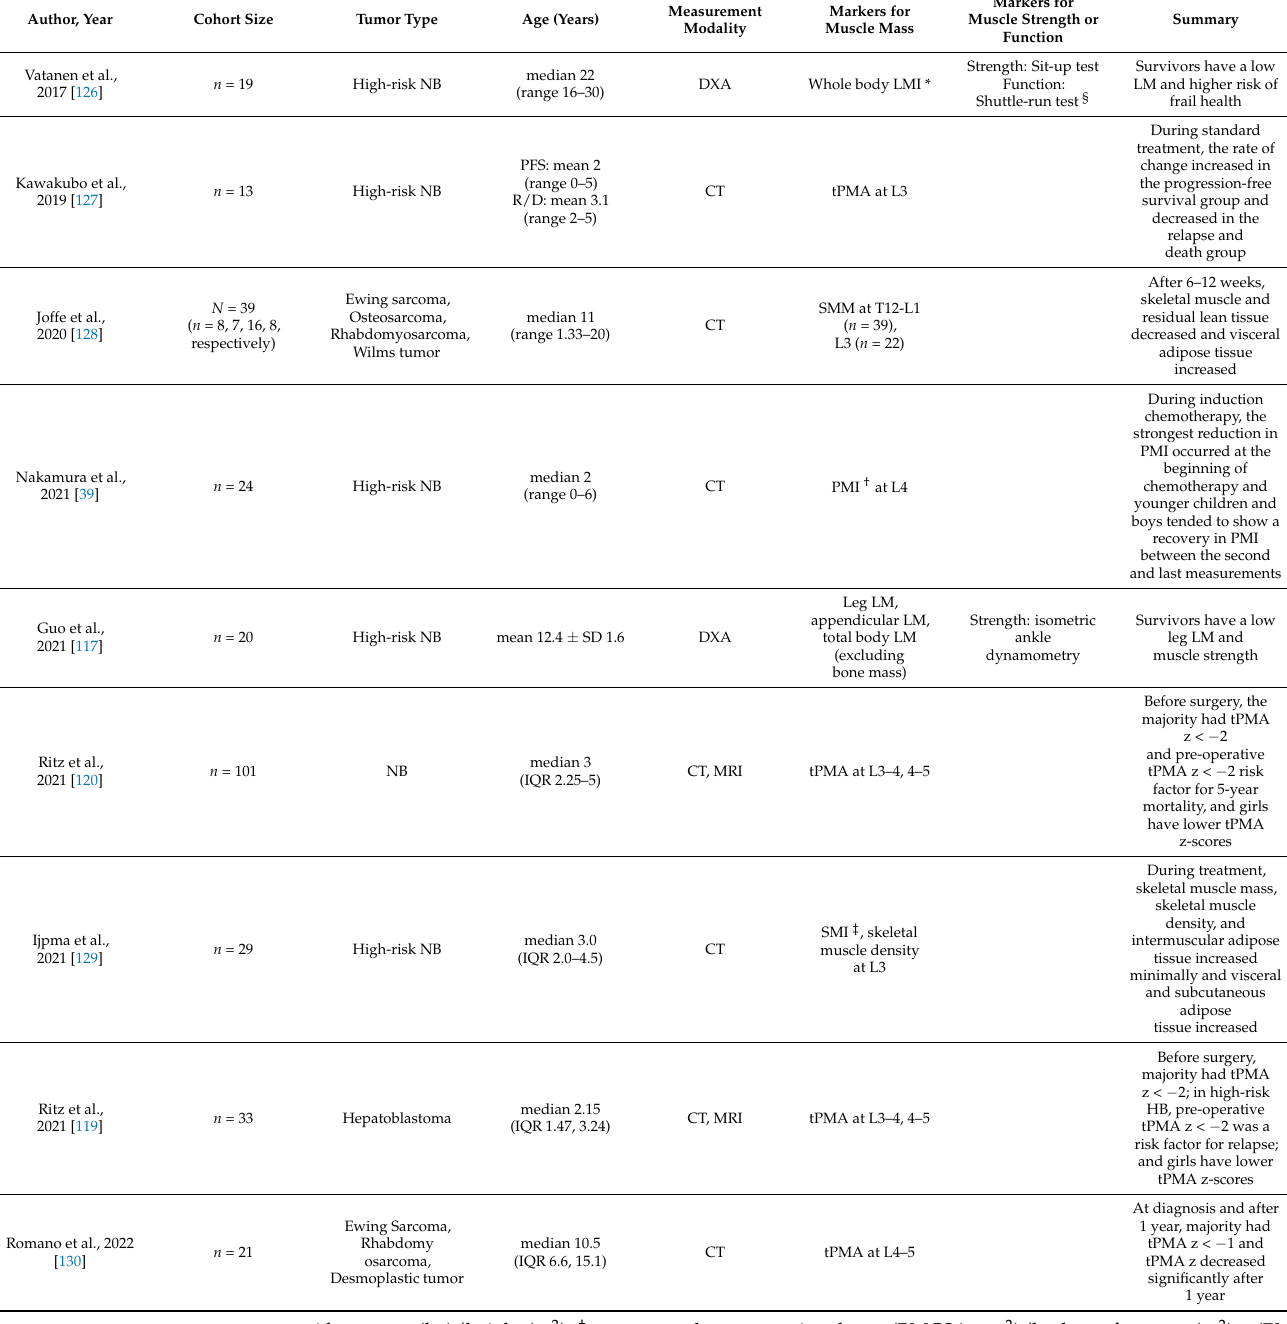
Table 2. Summary of current research on sarcopenia in children with solid organ